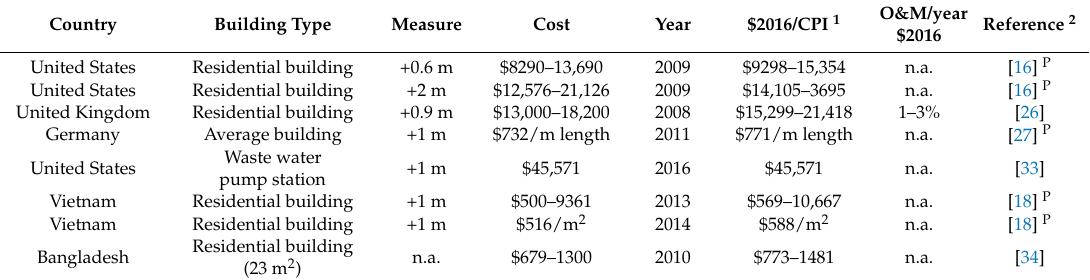
Table 2. Cost of dry flood-proofing buildings. The column “measure” shows for which water level measures are